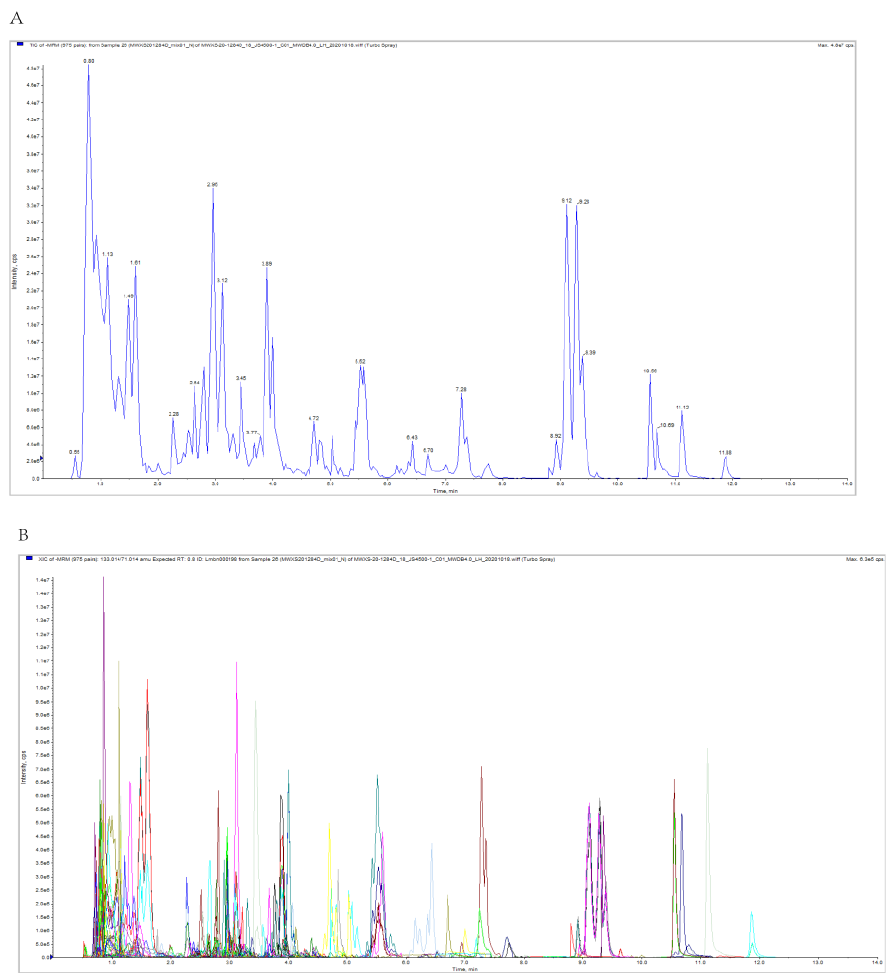
Figure 2. ( A ) TIC of one QC sample by mass spectrometry detection and ( B ) multi-peak detection plot of metabolites in the multiple MRM.